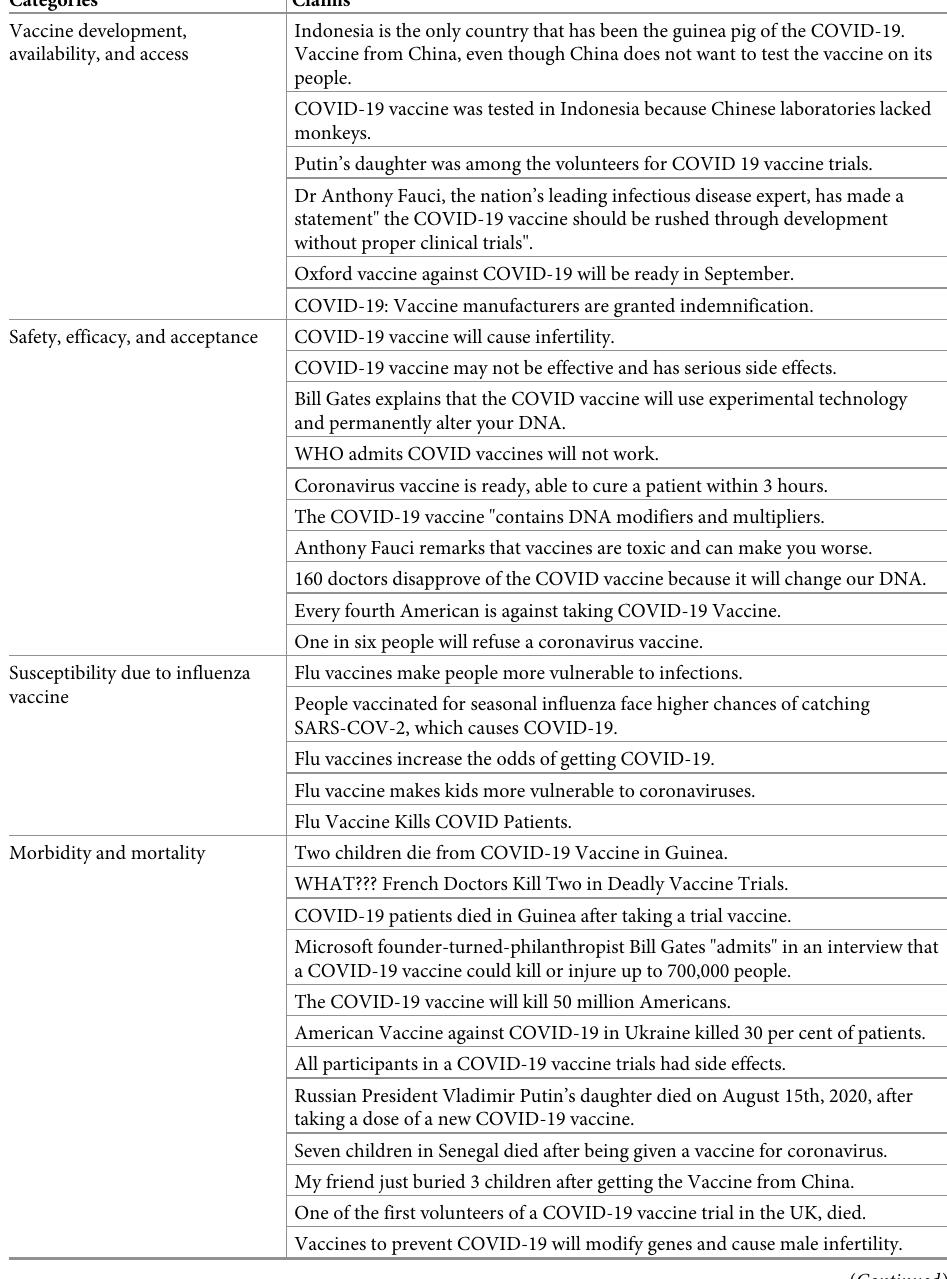
Table 2. Rumors and conspiracy theories related to COVID-19 vaccine circulating online, 31 December 2019–30 November